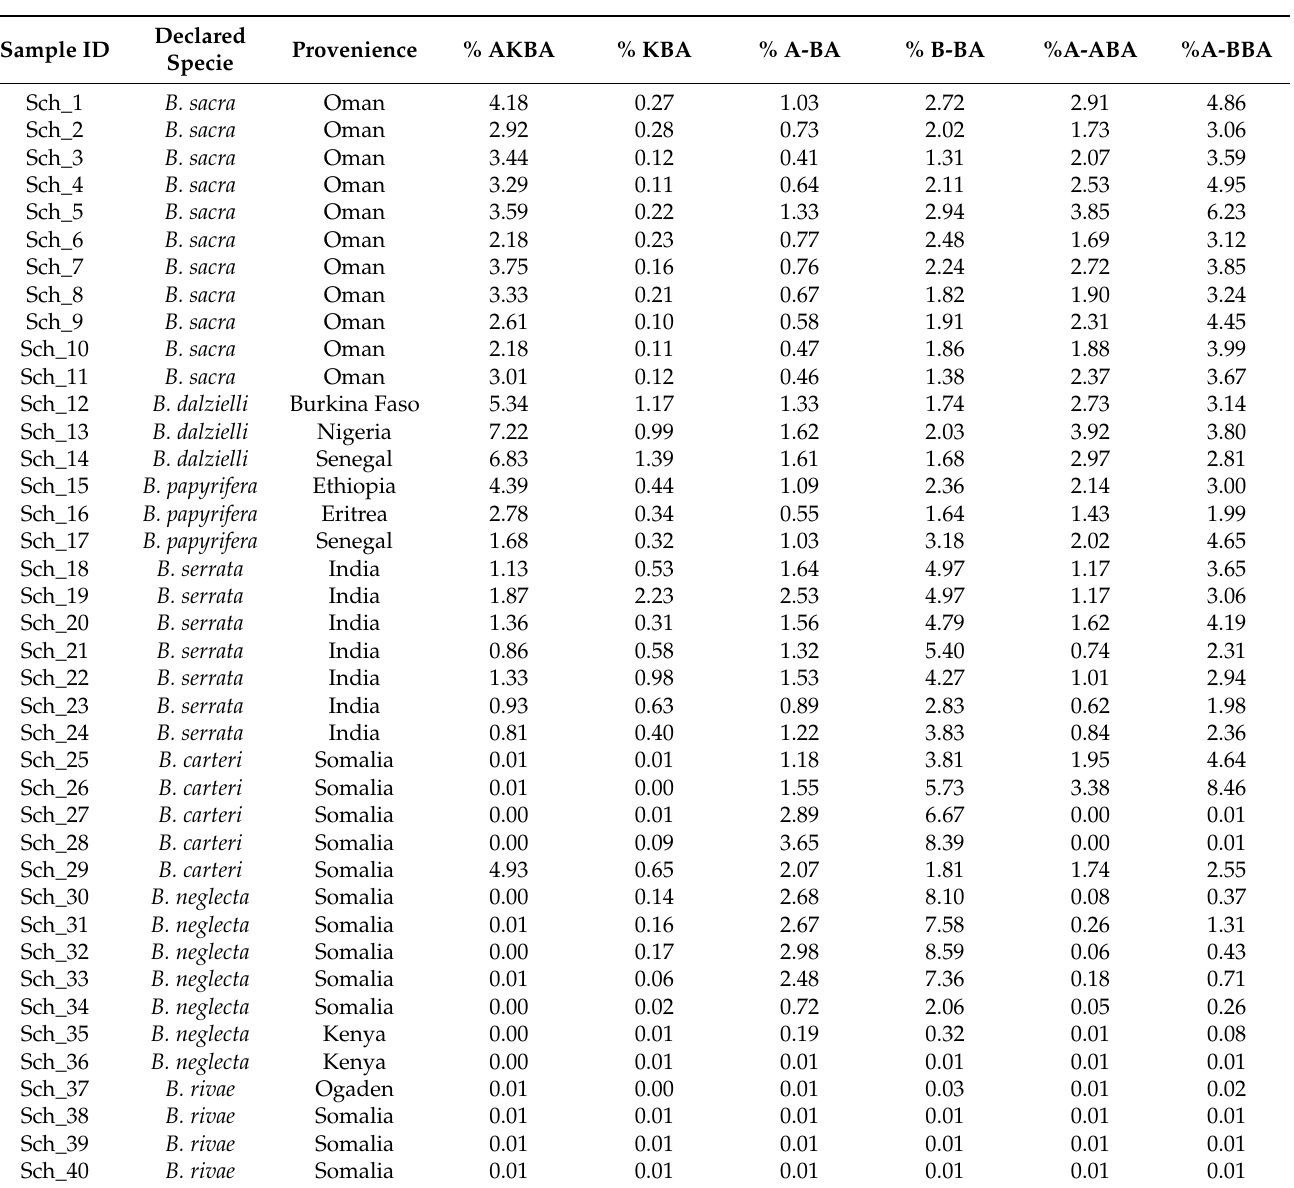
Table 3. Table listing all the samples used for the meta-multivariate approach. Each row reports the sample ID on the first column; declared species reports sample species, with “unk” if unknown; provenience reports the national or territorial origin of the sample, with “unk” if unknown. The remaining column reports the concentrations of each boswellic acid studied expressed as weight percentage or g/100 g. All the quantitation data are obtained from